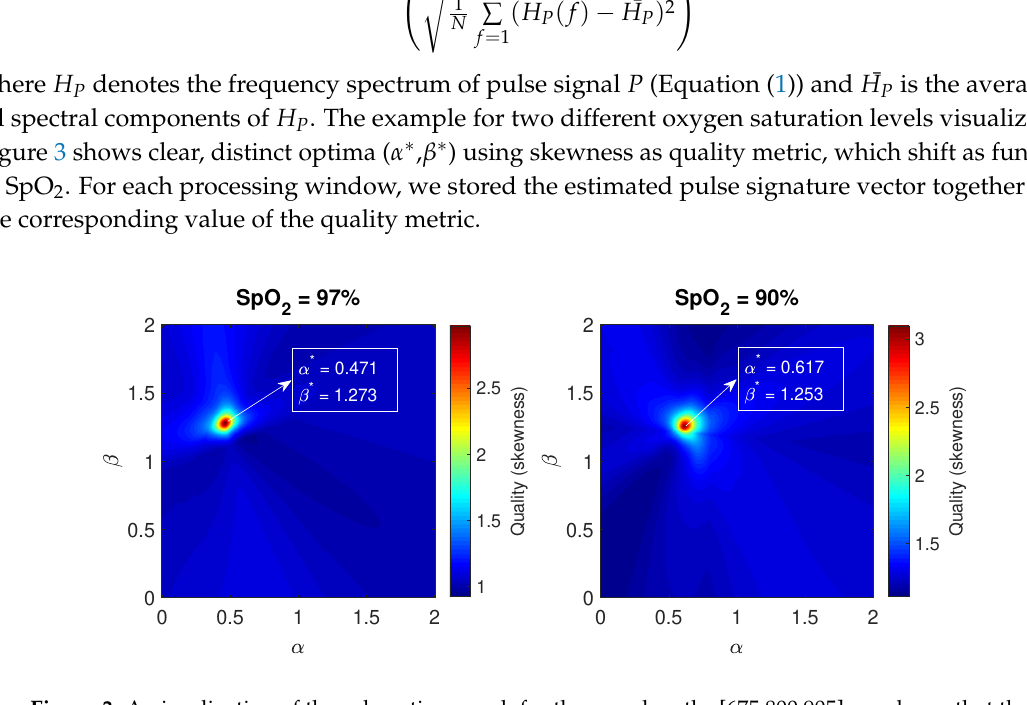
Figure 3. A visualization of the exhaustive search for the wavelengths [675,800,905] nm shows that the optimum, pulse quality, shifts as function of SpO 2 level. Here, α and β are the relative pulse amplitudes for 675 and 905 nm, respectively, and the amplitude for 800 nm is set to